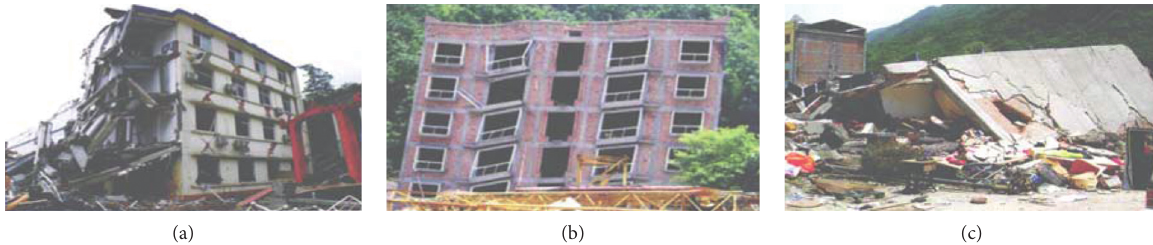
Figure 2: The three collapse modes of the building structure. (a) Local collapse, (b) global tilt, and (c) global